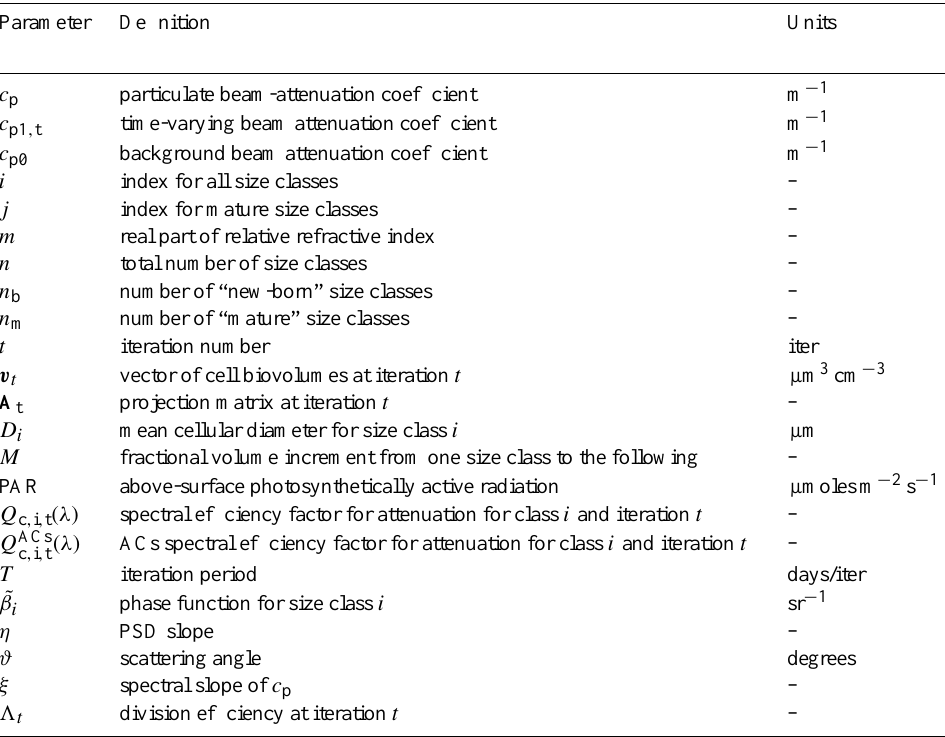
Table 1. Definitions and units of symbols (see also Table